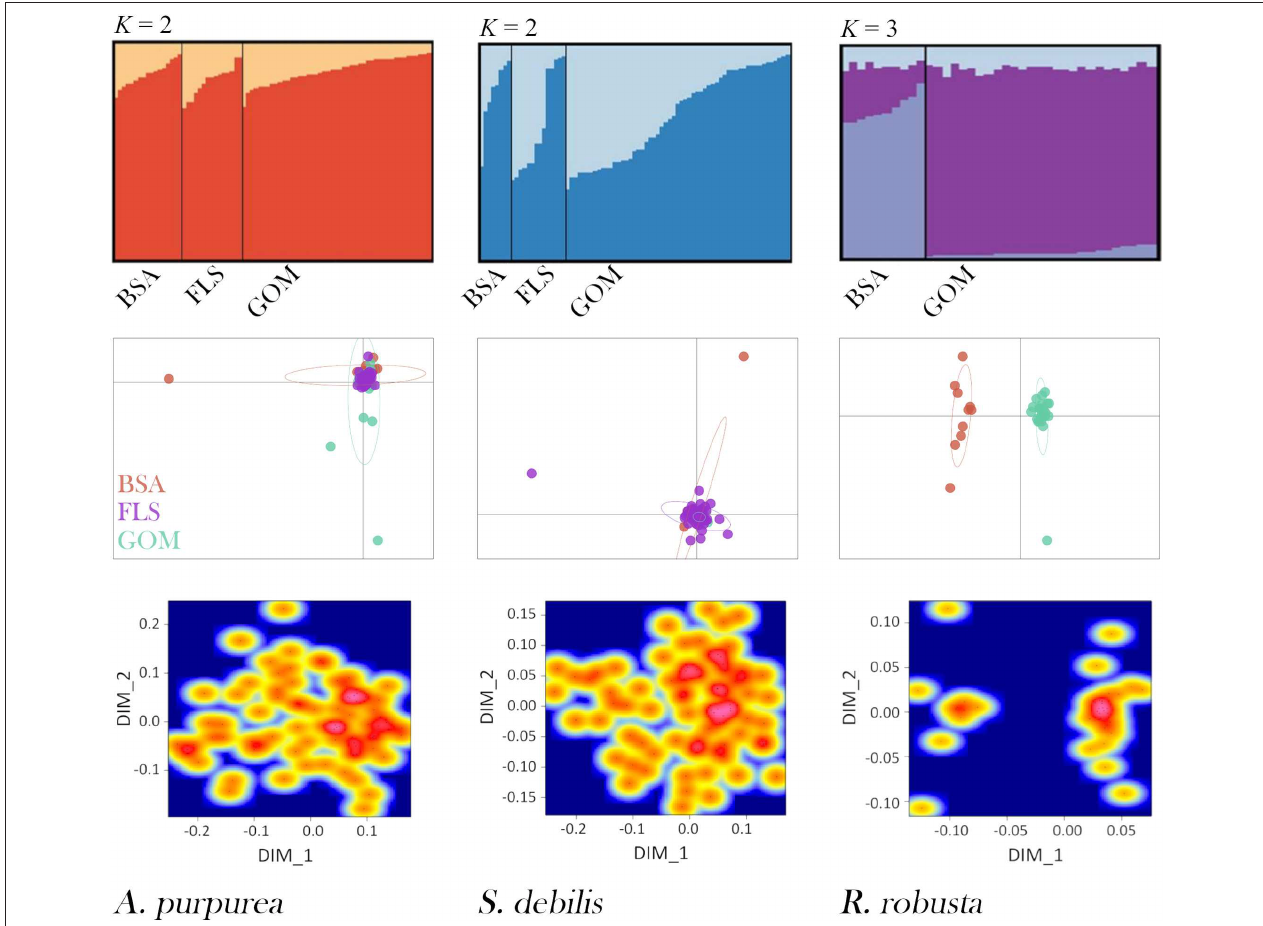
FIGURE 5 | DISTRUCT plots (top) , Principal Component Analyses (PCAs; middle ), and multidimensional scaling (MDS) heat maps (bottom) for Acanthephyra purpurea , Systellaspis debilis , and Robustosergia robusta . Collection localities are denoted “BSA” for Bear Seamount in the north Atlantic, “FLS” for the Florida Straits, and “GOM” for the Gulf of Mexico., The first two principal components shown for each species are as follows: A. purpurea PC1 = 3.5%, PC2 = 3.1%, S. debilis PC1 = 2.7%, PC2 = 2.5%, and R. robusta PC1 = 5.9%, PC2 = 3.6%.